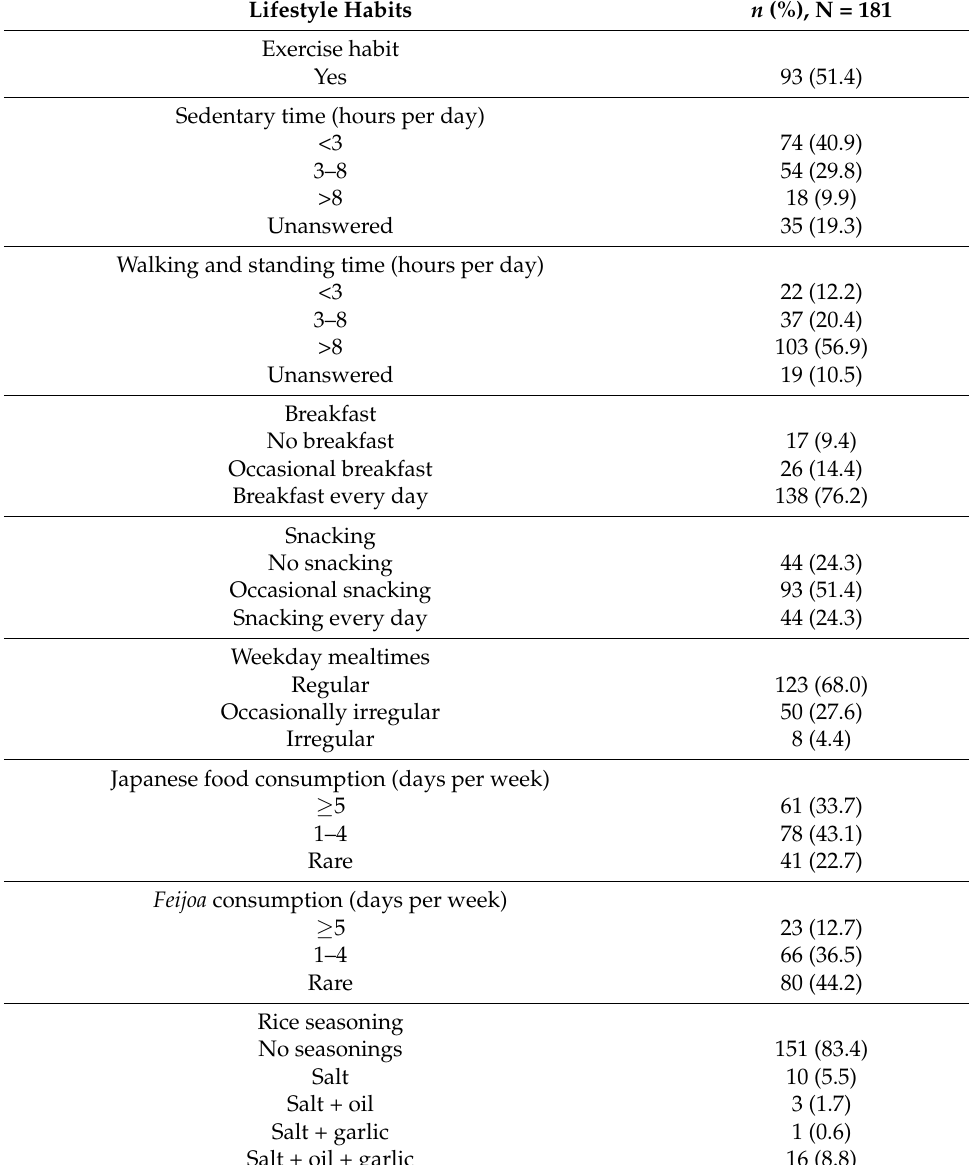
Table 2. Lifestyle habits of the study participants.